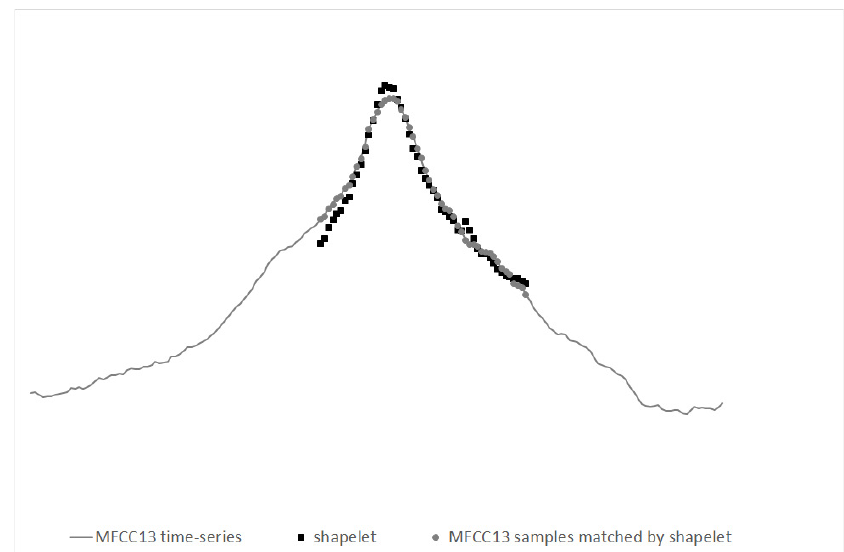
Figure 7. Exemplary shapelet for MFCC13, together with the part of MFCC13 evolution matching this shapelet